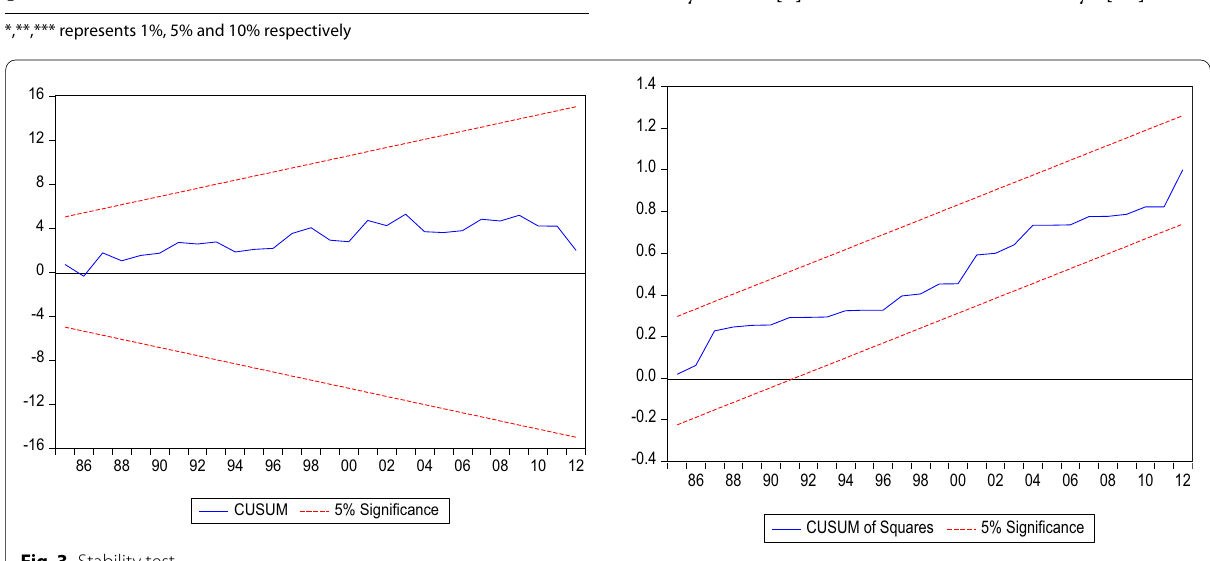
Fig. 3 Stability